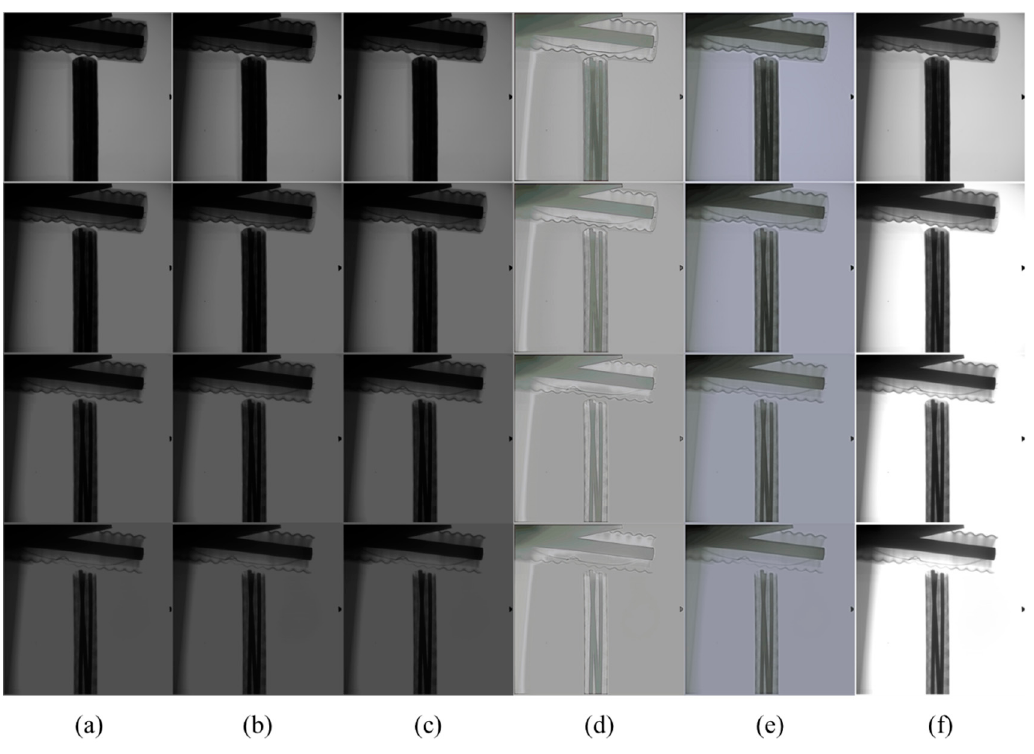
Figure 12. The contrast enhancement results of different methods (the voltage is 90 kV, 120 kV, 150 kV, and 180 kV from top to bottom). ( a ) The raw images; ( b ) CLAHE; ( c ) LCM-CLAHE; ( d ) Retinex-Net; ( e ) Zero-DCE; and ( f ) our method.